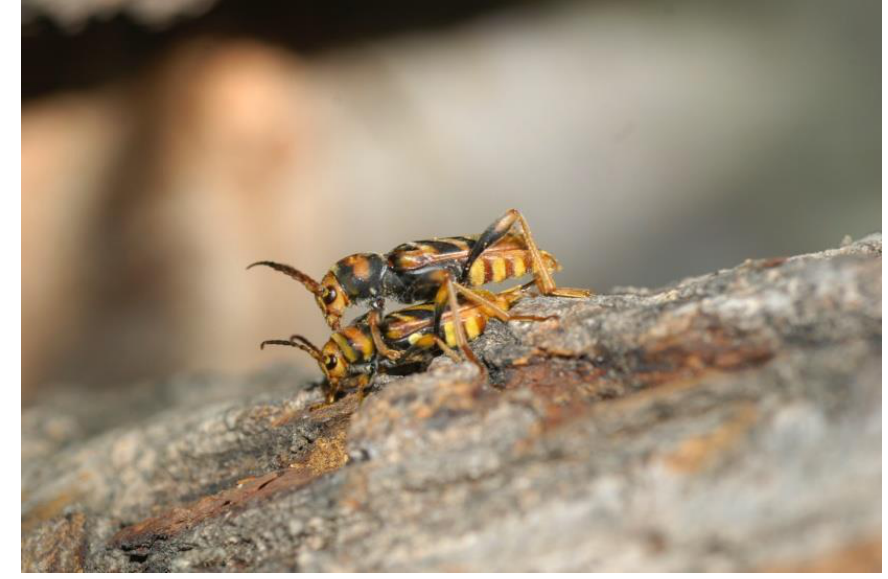
Figure 2. X. chinensis couple mating on a mulberry trunk. Male on top. (Photo V. Sarto i Monteys).